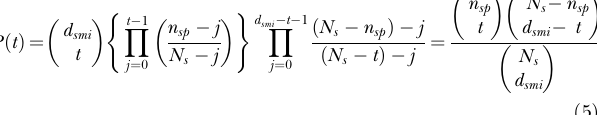
Figure S1. The PEI for All Breast Cancer Cohorts Figure S2. Vijver Figure S3. Wang